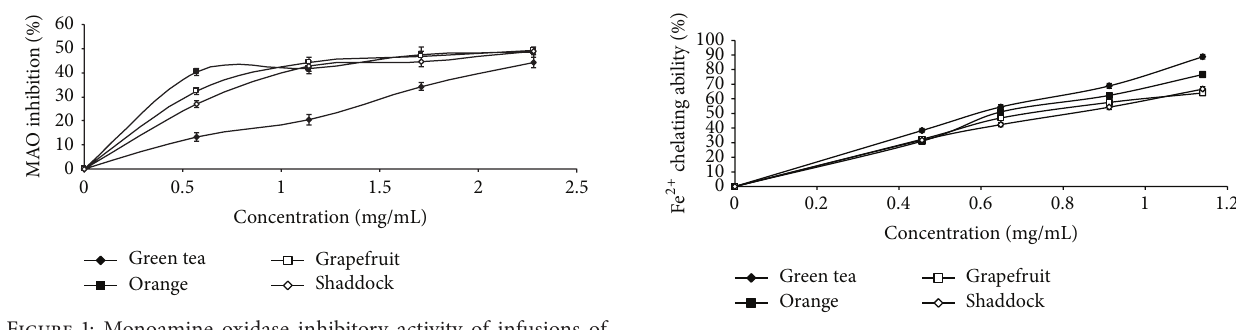
Figure 3: Fe 2+ chelating abilities of infusions of green tea and some citrus peels. Values represent means ± standard deviation of triplicate readings.